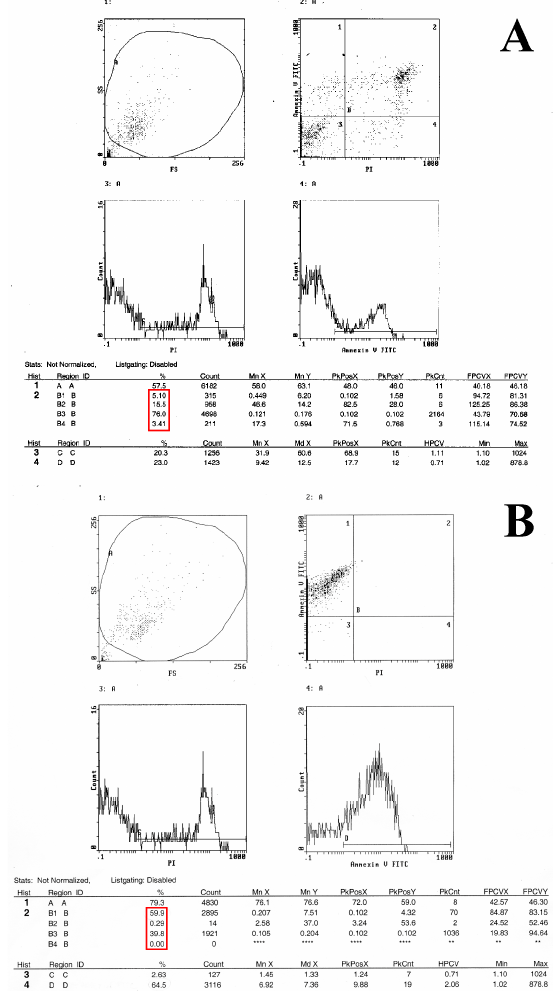
Figure 8. Flow cytometry analysis of untreated ( A ) and treated ( B ) cells with graded concentrations of metformin, using an Annexin V-FITC assay. ( A ) The early apoptotic death rate of untreated HT-29 cells was 5.1% (line 2, third column of the Table below the Figure). ( B ) The early apoptotic death rate of the HT-29 cells treated with MET was remarkably higher than the control. The highest rate of apoptotic cells was achieved with the 50 mM treatment for 48 h, i.e., 59.9% (line 2, third column of the Table below the Figure). In the red box are evident the apoptotic rates for untreated (panel A), and